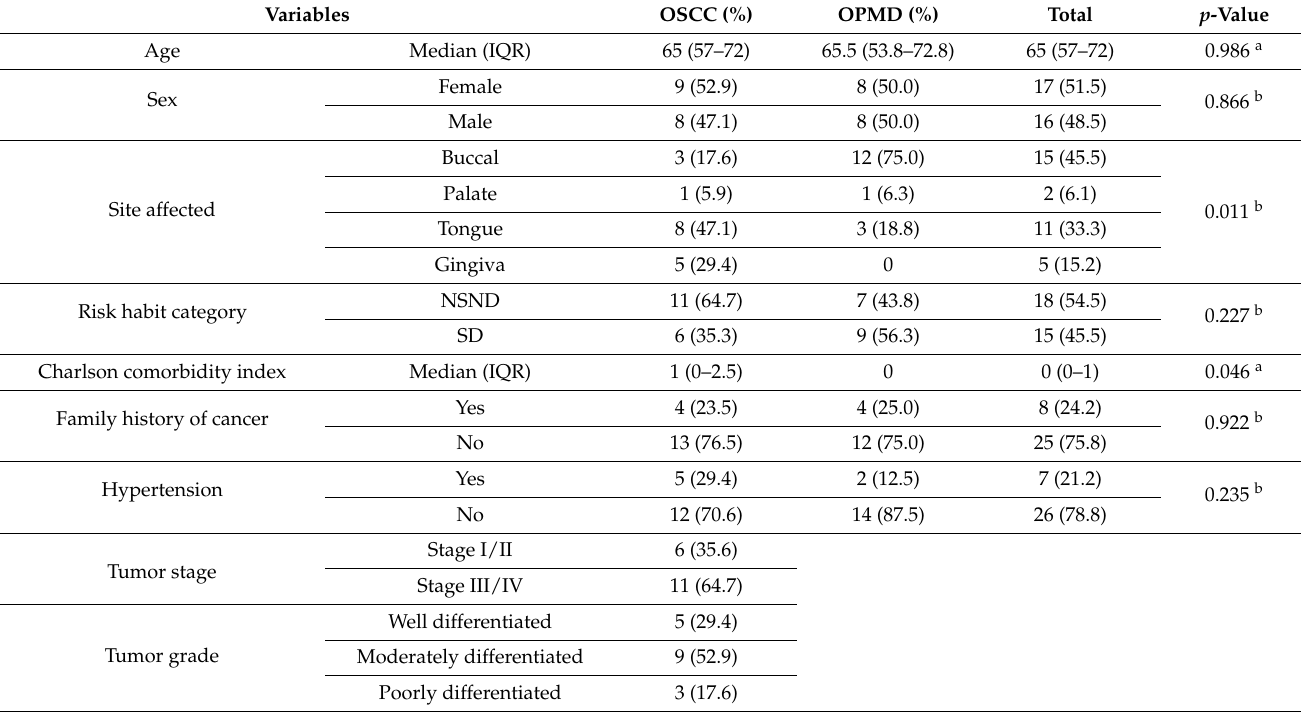
Table 1. Characteristics of patients included for RRBS